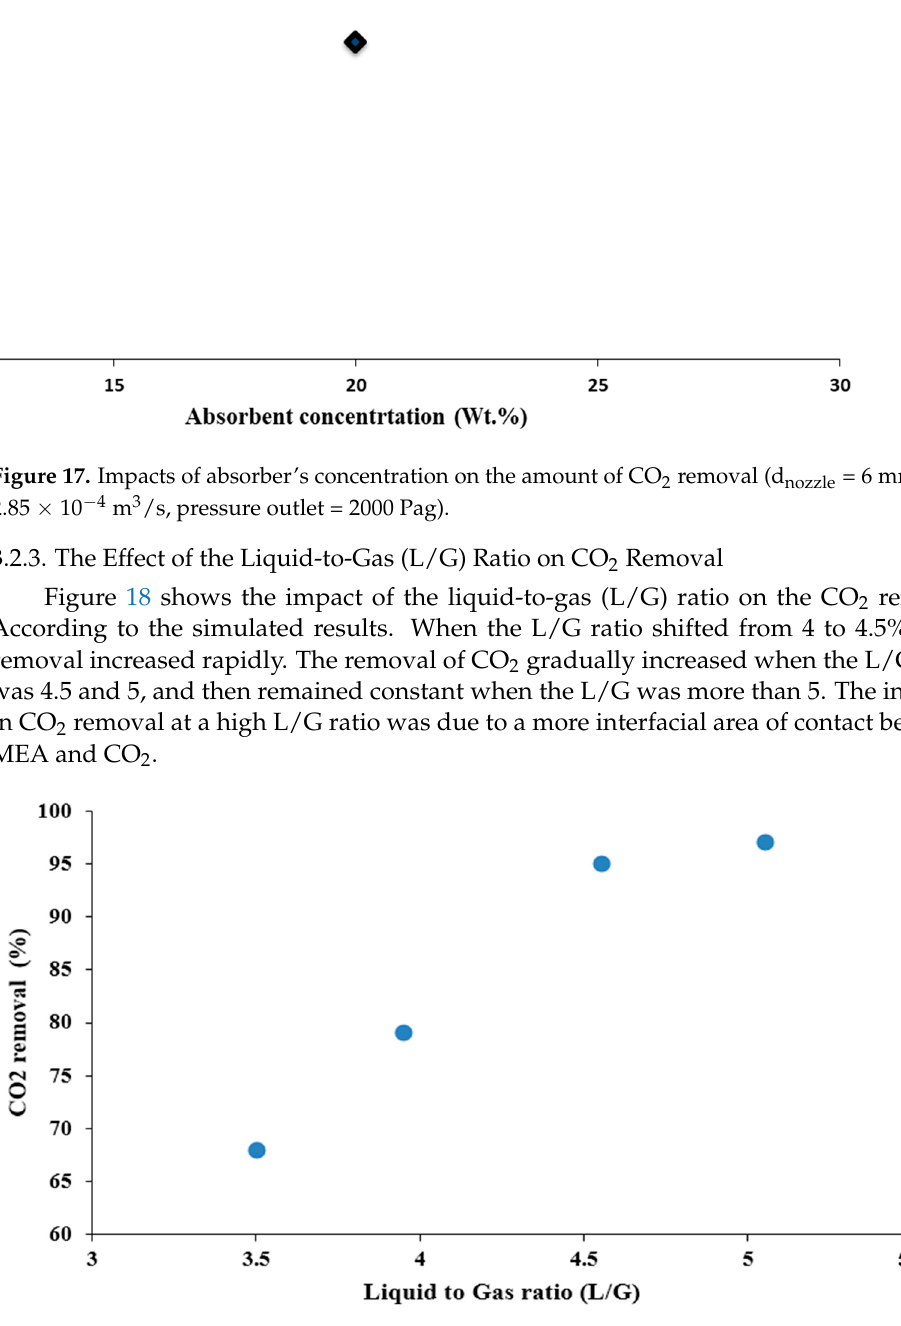
Figure 18. Effect of the liquid-to-gas (L/G) ratio on the percentage of CO 2 removal.